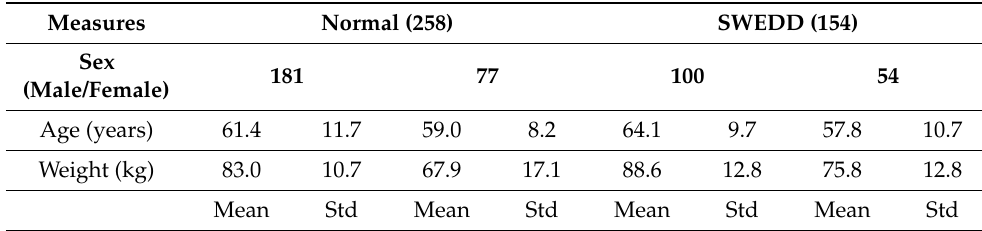
Table 1. Characteristics of the cohort of normal and SWEDD images used in this contribution. Measures Normal